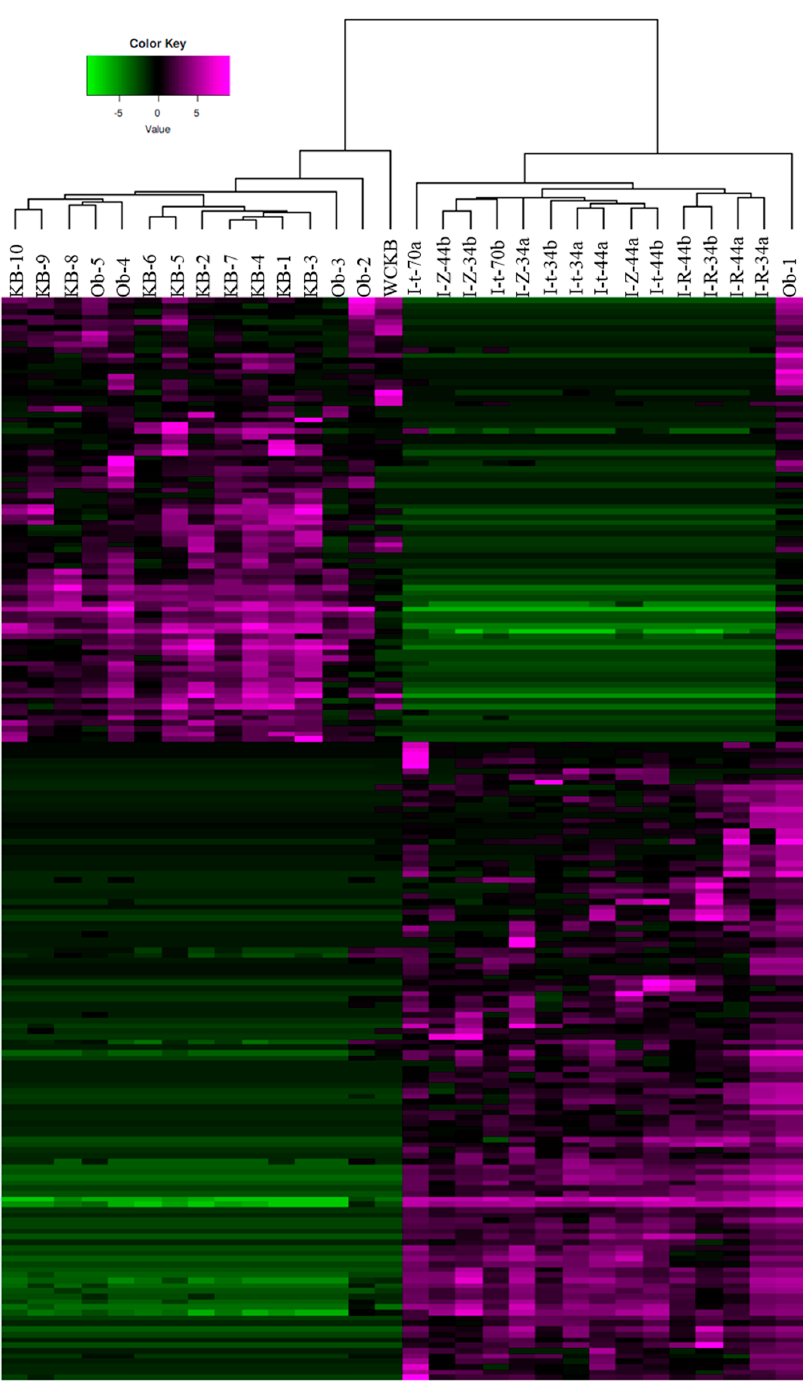
Figure 3. Hierarchical cluster analysis based on the 200 most abundant OTUs from the intestinal bacterial communities of white-leg shrimp.